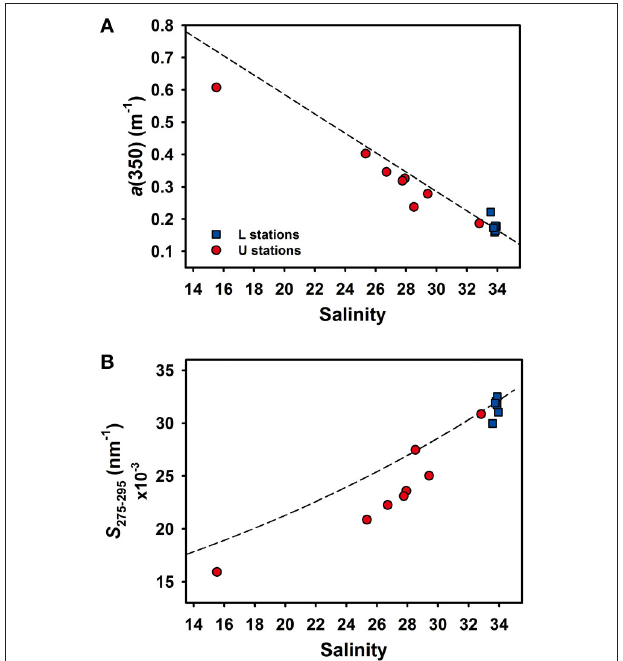
FIGURE 6 | Relationships between salinity and (A) a (350) and (B)salinity and S 275 – 295 in surface waters including mid salinity (U stations, red circles) and high salinity (L stations, blue squares) samples in November 2014. Dashed lines are conservative mixing curves constructed using the Unosumai River as the riverine end-member and station L6 as the marine